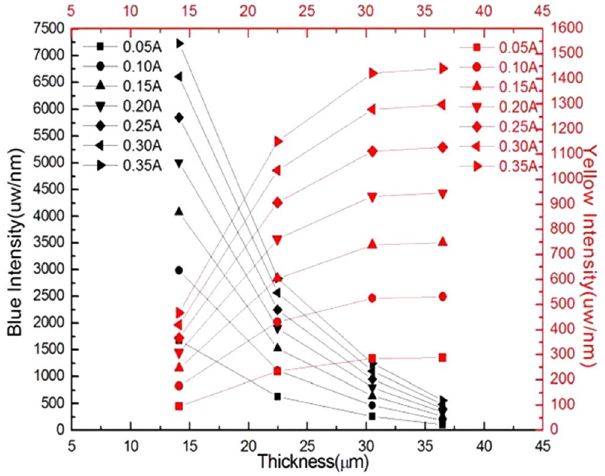
Figure 4. Radiant flux of phosphor coating layers with different thickness at a range of 350 nm–850 nm. The blue intensity is obtained at 450 nm, and the yellow intensity at 590 nm.